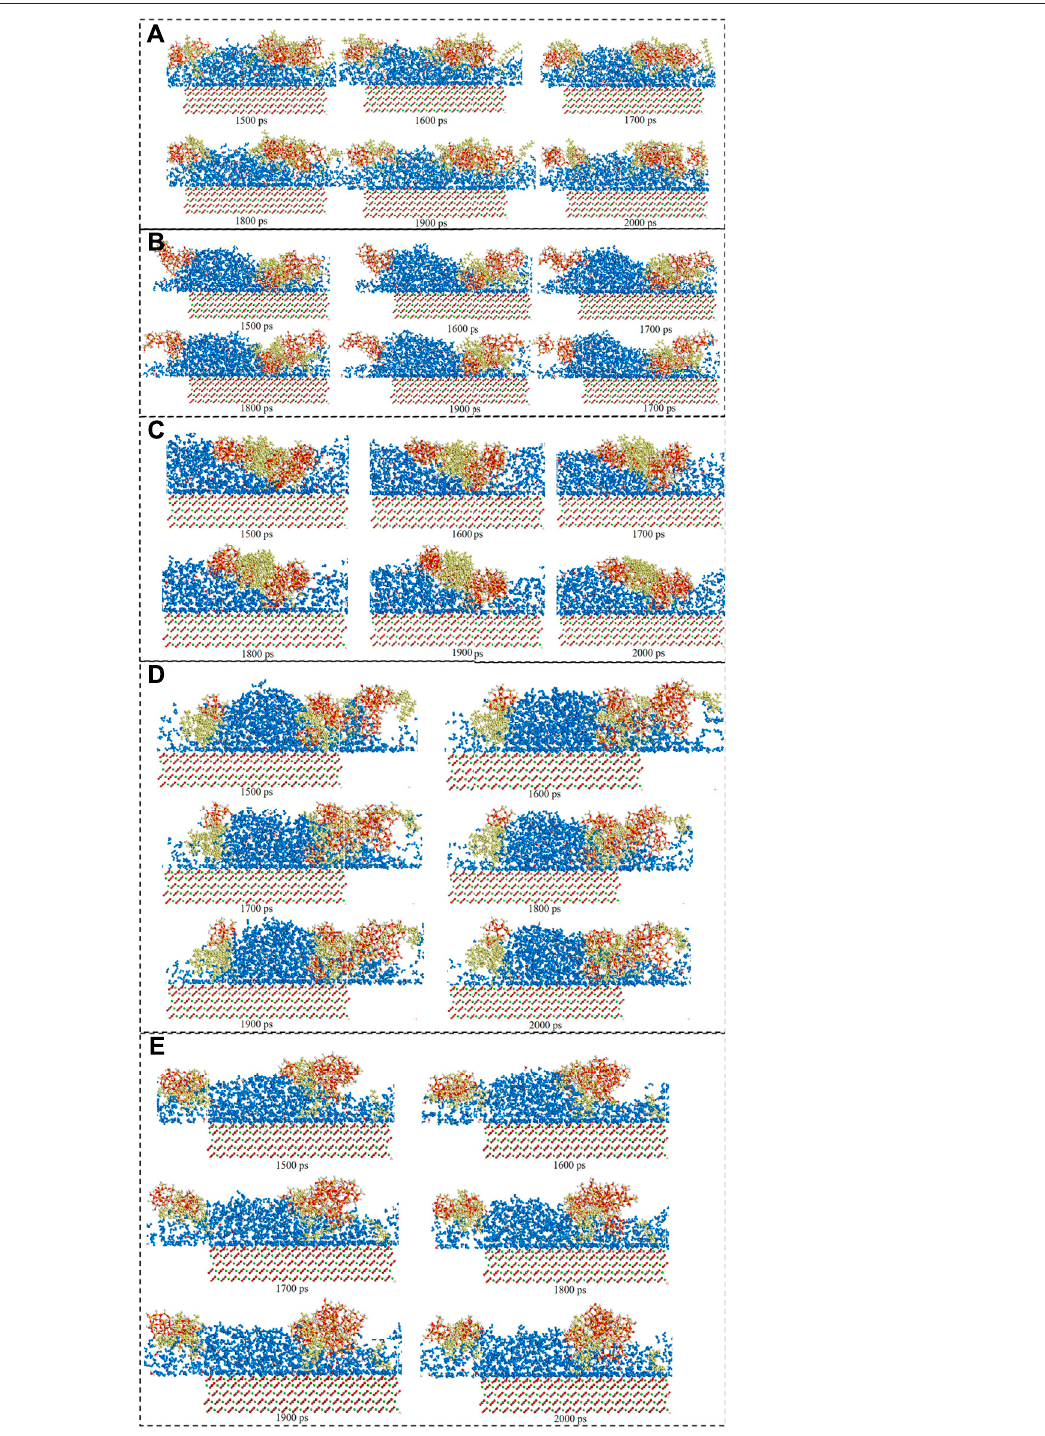
Frontiers in Chemistry |